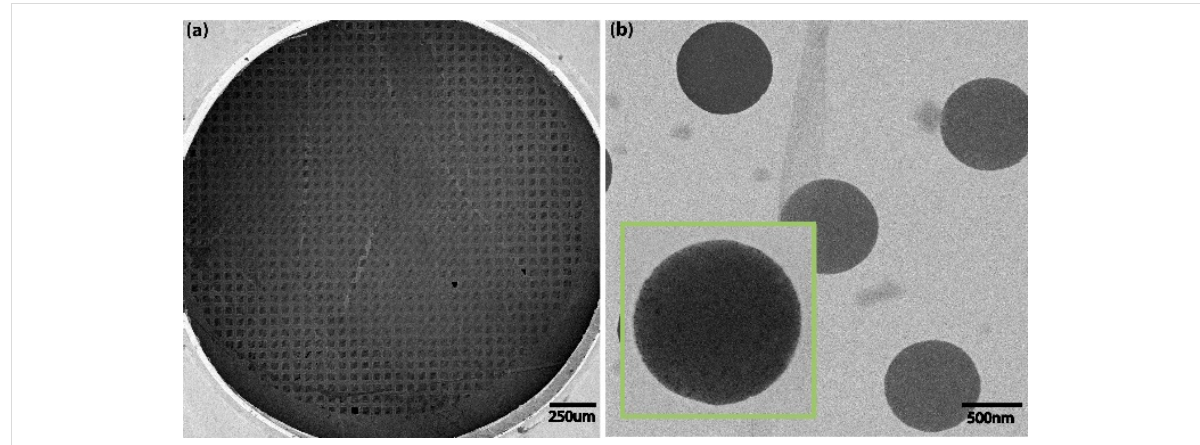
Figure 4: Helium ion microscope (HIM) image of a transferred carbon nanomembrane (CNM) made using 3 min (1.8 mC/cm 2 ) of electron irradiation (50 eV) on a 2-I-BPT self-assembled monolayer. (a) 2500 × 2500 µm HIM image of the 2-I-BPT CNM transferred onto a TEM grid. (b) Magnification of (a) shows grid holes covered by a mechanically stable CNM with a distinct porosity (inset, green